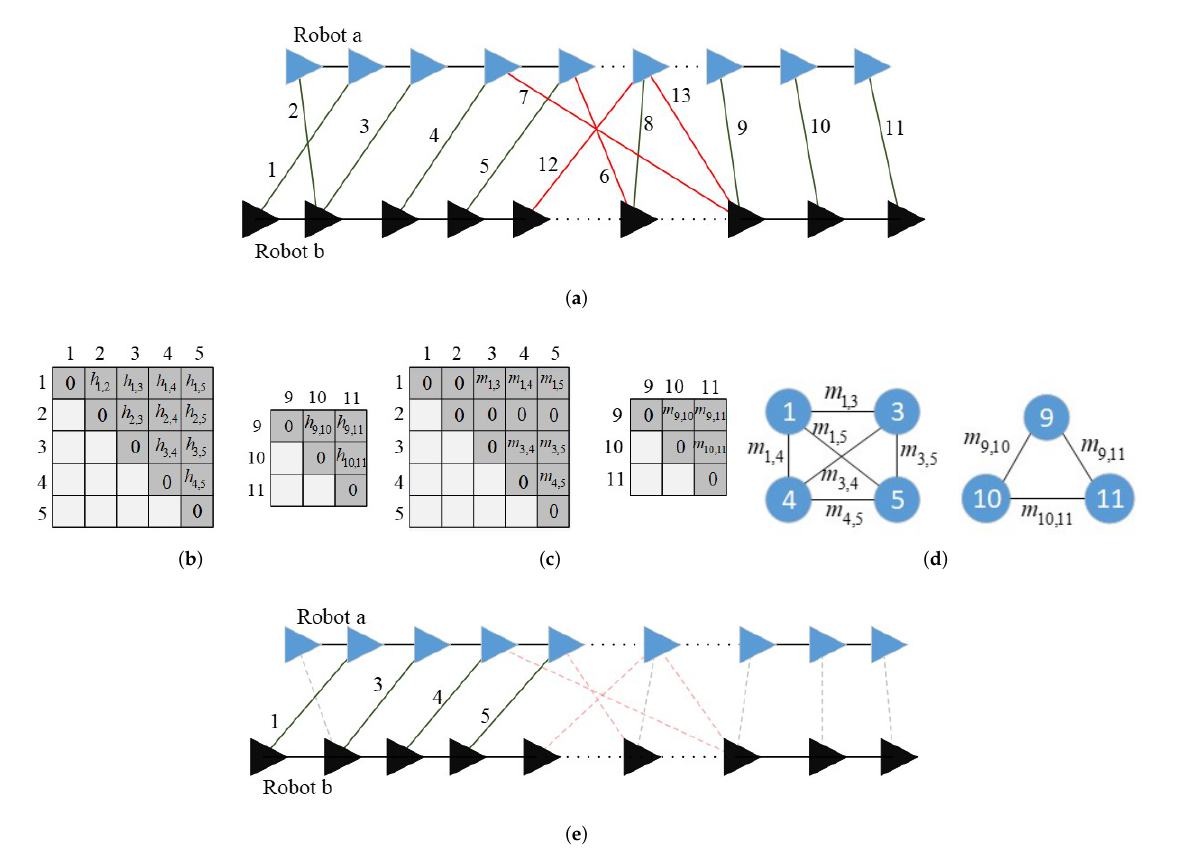
Figure 2. A small case for the proposed loop closure selection method. ( a ) Diagram of inter-robot measurement based on continuity of similar scenes. The solid black line in the local trajectory of the single robot connects two sequential pose nodes, while the dotted line connects two non-sequential pose nodes. ( b ) Topologically correct matrix. ( c ) Cliques Topologically correct and consistent matrix. ( d ) corresponding to the overlapping trajectory regions. ( e ) Selected